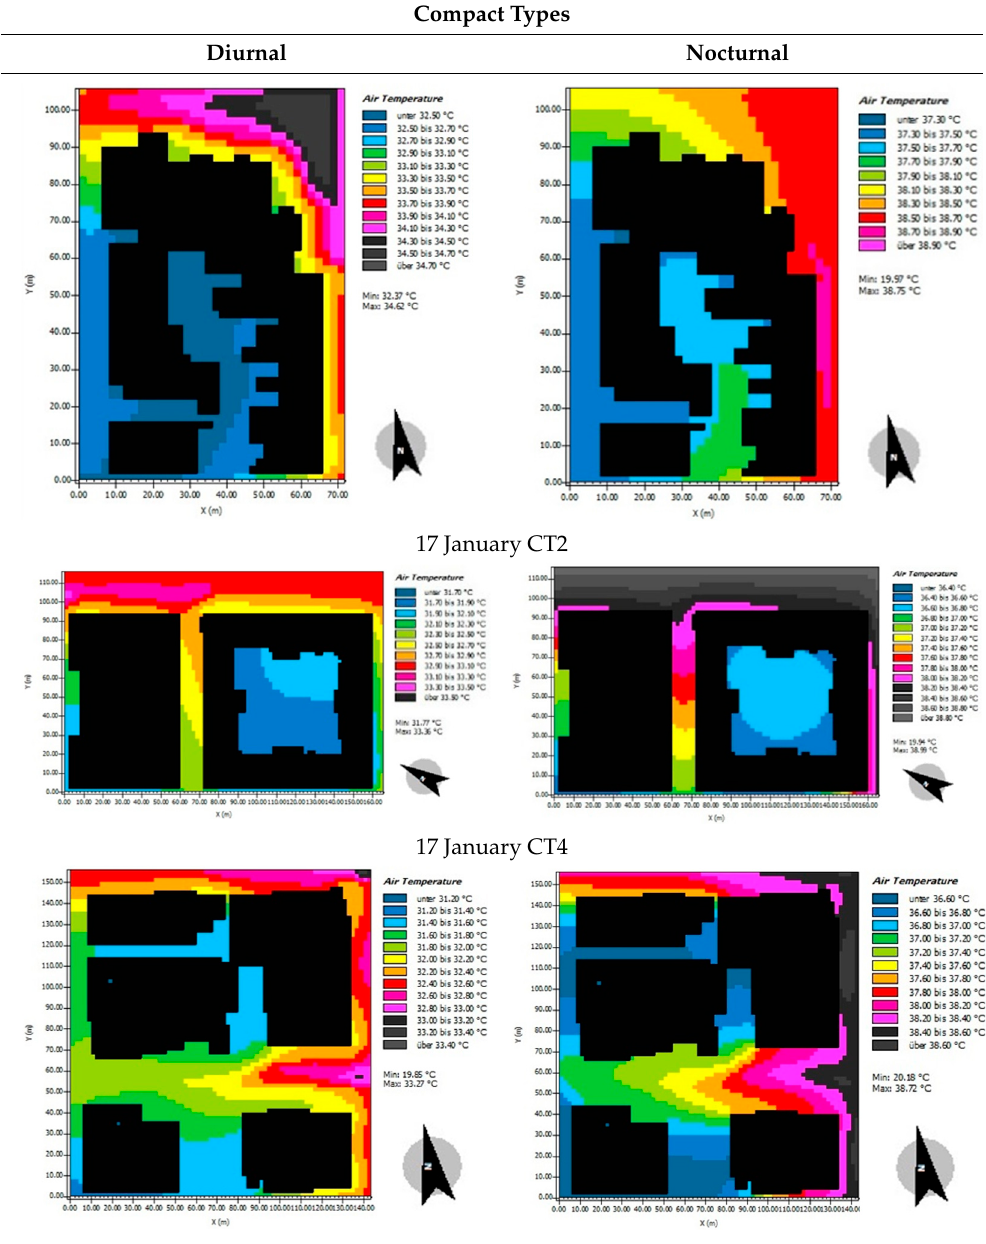
Table 8. A comparison summary of diurnal and nocturnal ambient air temperature distribution map across compact-type arrangements on 17th February.